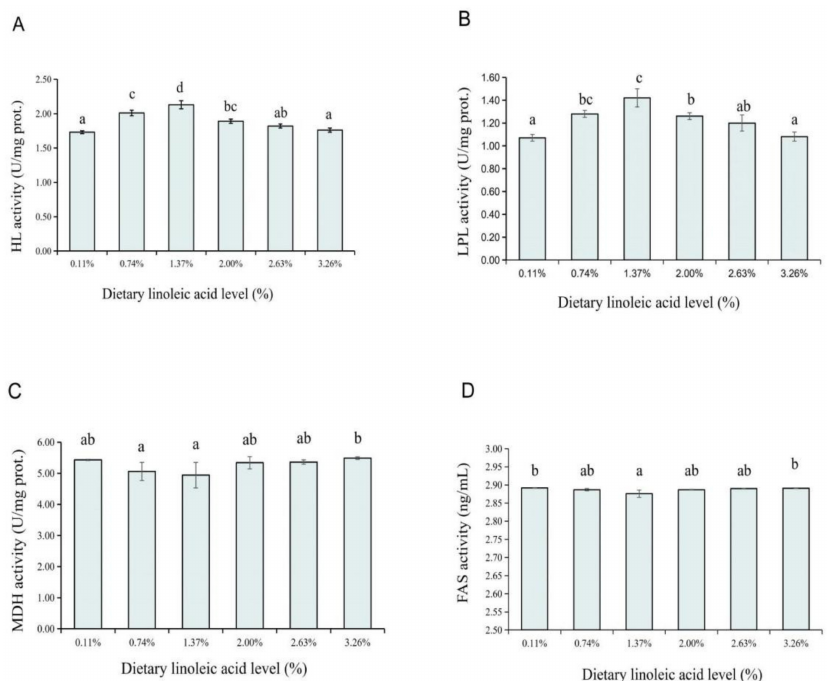
Figure 3. Effects of dietary LA levels on HL (hepatic lipase, ( A )), LPL (lipoprotein lipase, ( B )), MDH (malate dehydrogenase, ( C )), and FAS (fatty acid synthase, ( D )) activities in liver of coho salmon Oncorhynchus kisutch alevins. a–d : Means that do not share similar letter in group are significantly different, p <